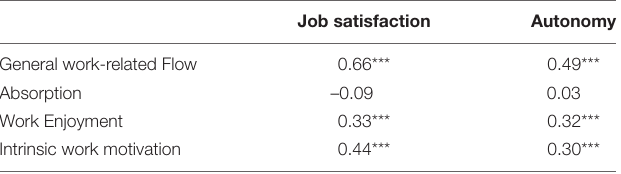
TABLE 6 | Correlations between WOLF factors and two external factors (job satisfaction and autonomy) based on the B-ESEM model with three S-factors and one